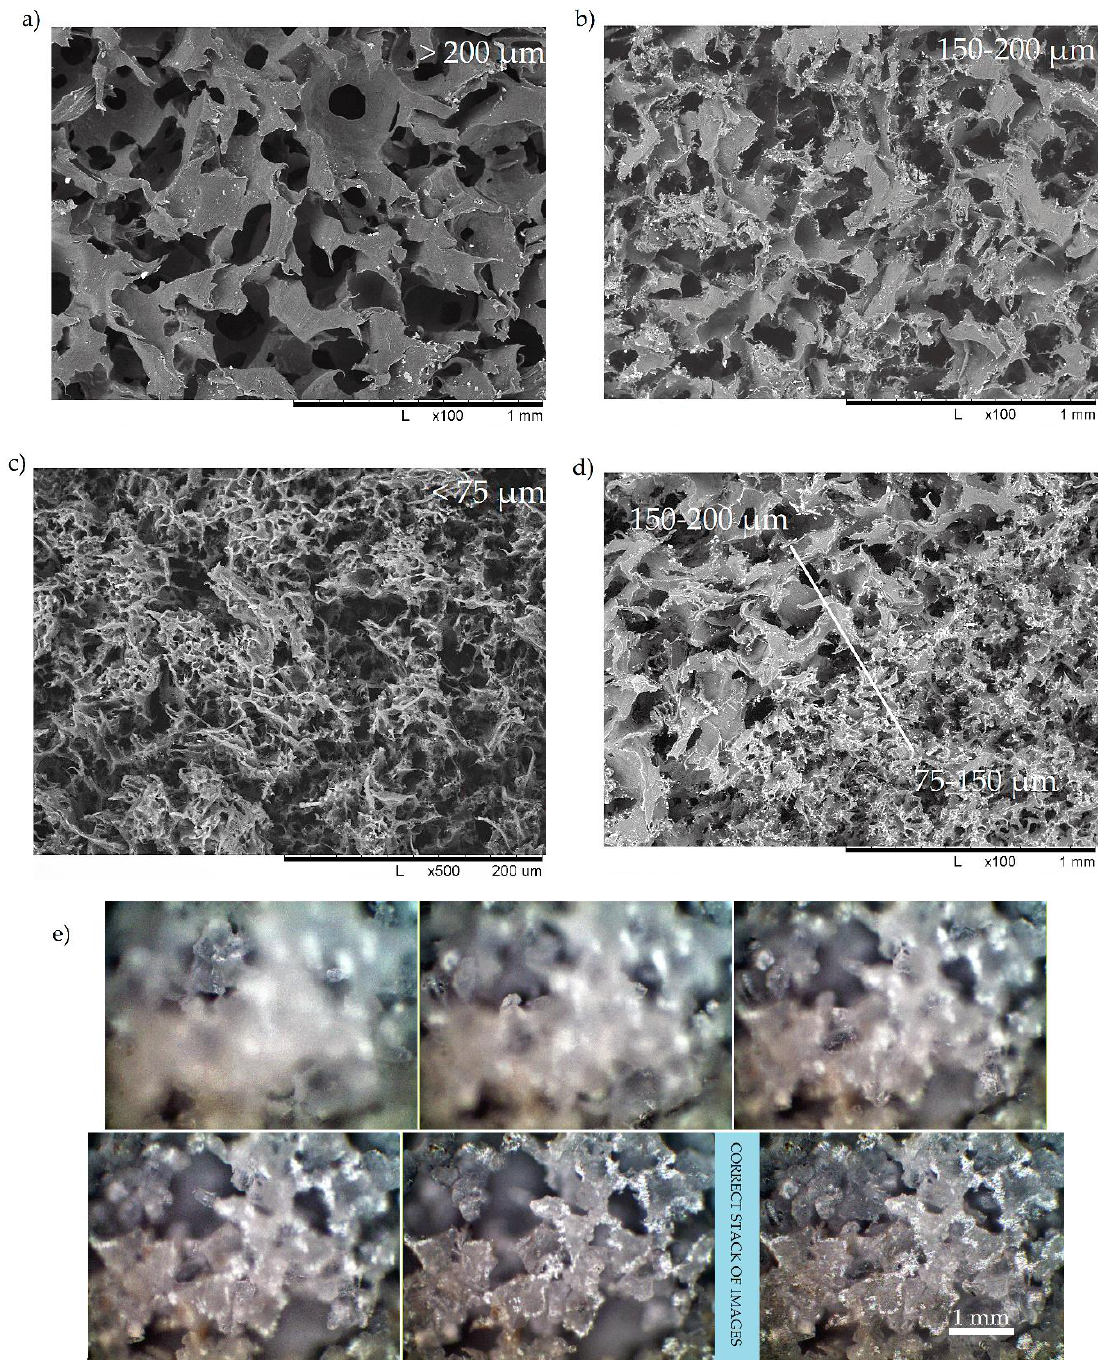
Figure 3. The scanning electron microscopy (SEM) images of porous UHMWPE uniform ( a , b , c ) and hybrid ( d ) structure fabricated from a powder having different average particle size, ( e ) a stack of optical images and deep focus pseudo-3D reconstructed image.